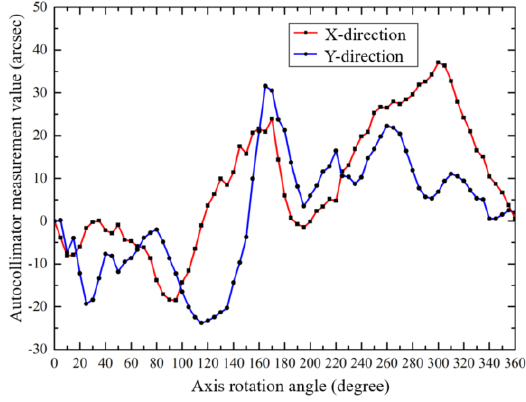
Figure 8. The tilt error of the mirror.